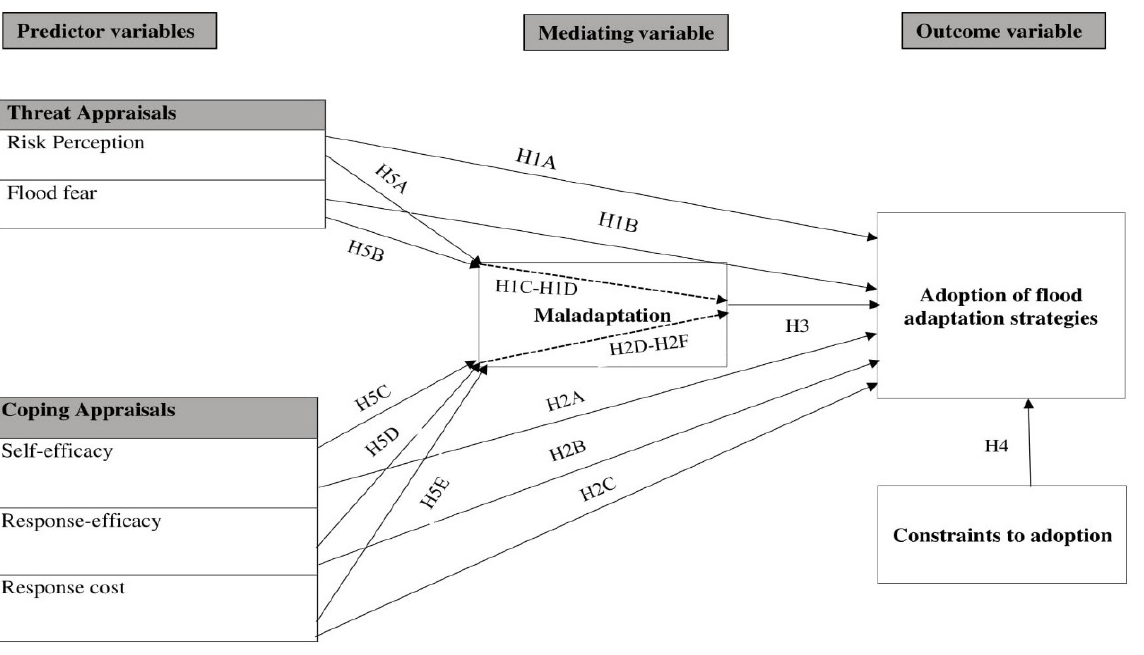
Figure 1. Model of flood risk adaptation behavior and hypotheses. Straight and dashed arrows depict predicted direct effects and mediation (indirect) effects respectively.